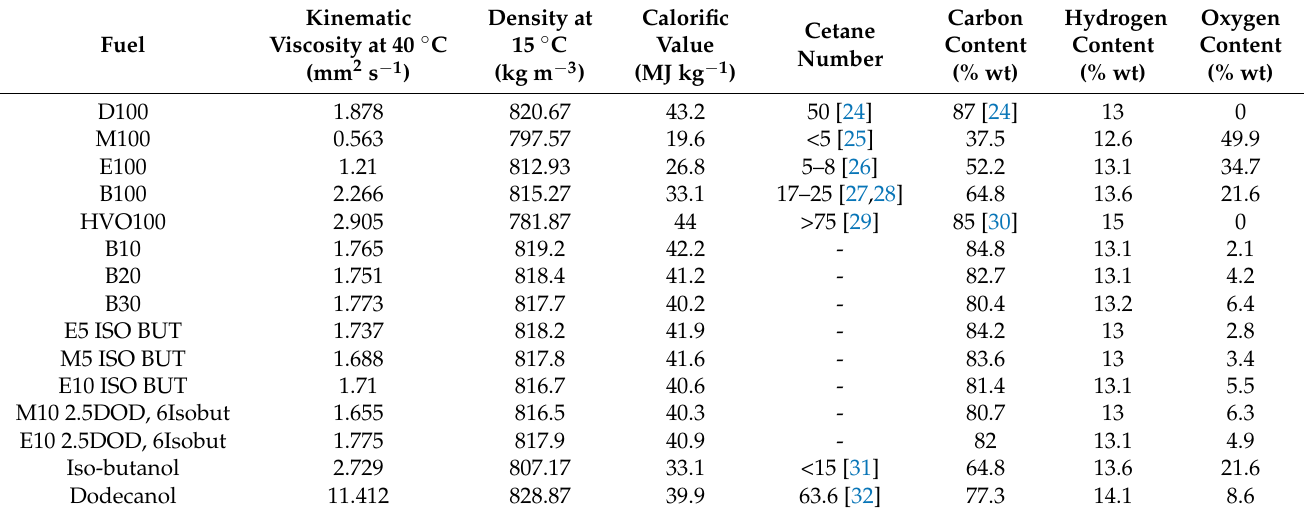
Table 3. Basic specifications of the tested